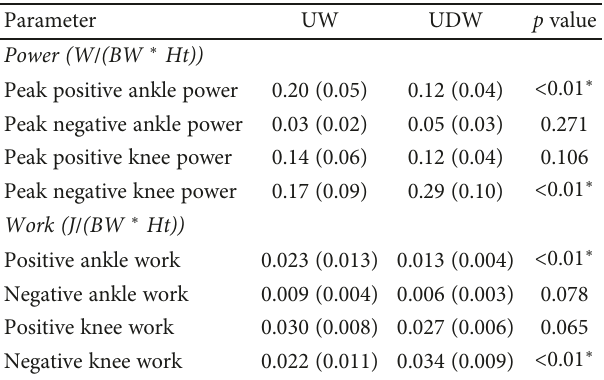
Table 2: Mean (standard deviation) of ankle and knee joint peak power and work during UW and